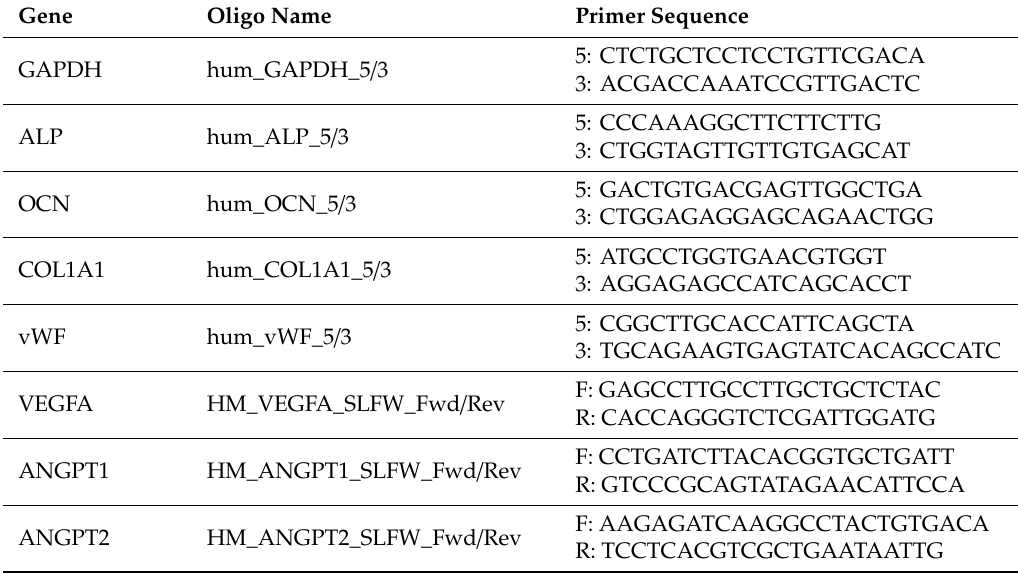
Table 1. Primer sequences for